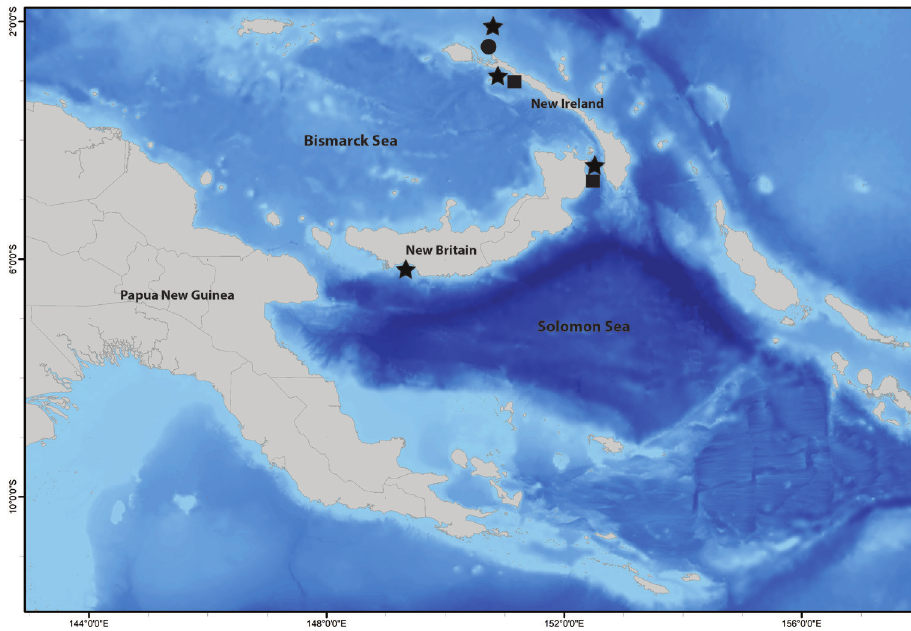
Figure 1. Sampling sites of type material of Marphysa banana sp. nov. (black circle), Marphysa papuaensis sp. nov. (black star), and Marphysa zanolae sp. nov. (black square) in Papua New